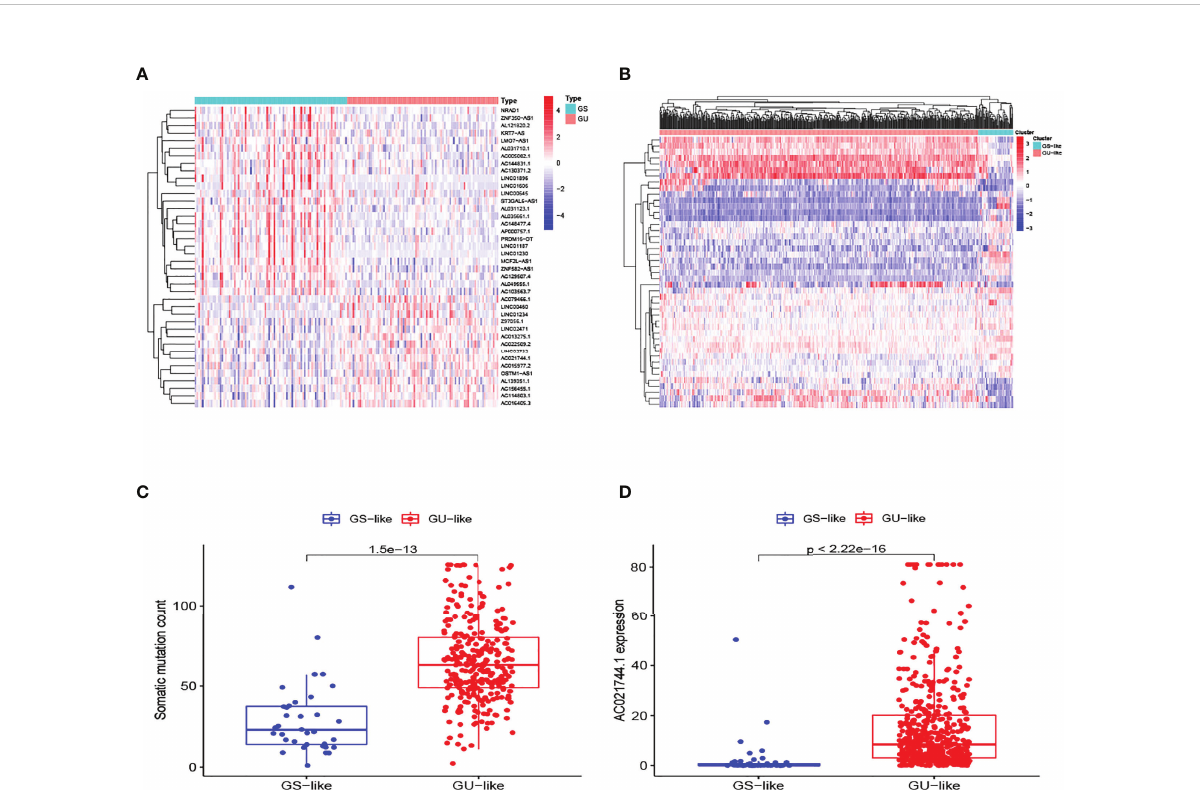
FIGURE 2 Identi fi cation of GILncs and whole sample cluster. (A) The heatmap plot of lncRNAs based on mutation frequency. (B) Hierarchical clustering analysis of all 539 samples. GU-like type is colored in red and GS-like type is colored in blue. (C) The boxplot of somatic mutation count comparison between GU-like type and GS-like type. (D) The boxplots of AC021744.1 expression level in the GU-like type and GS-like